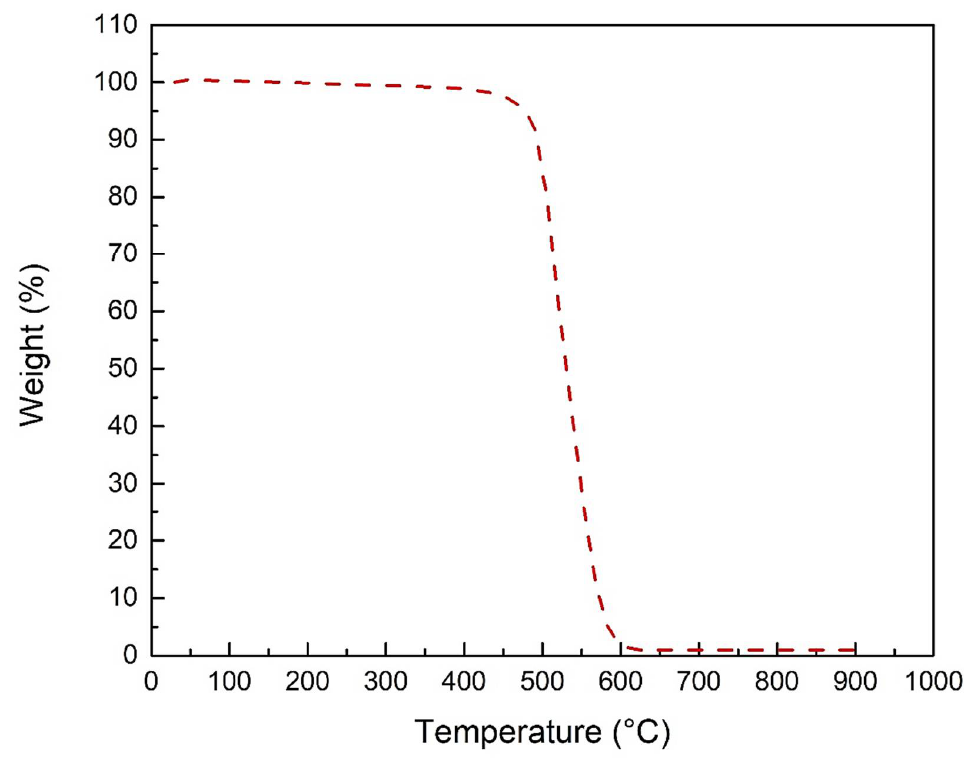
Figure 8. Thermogravimetric analysis of MWCNTs-Ag.